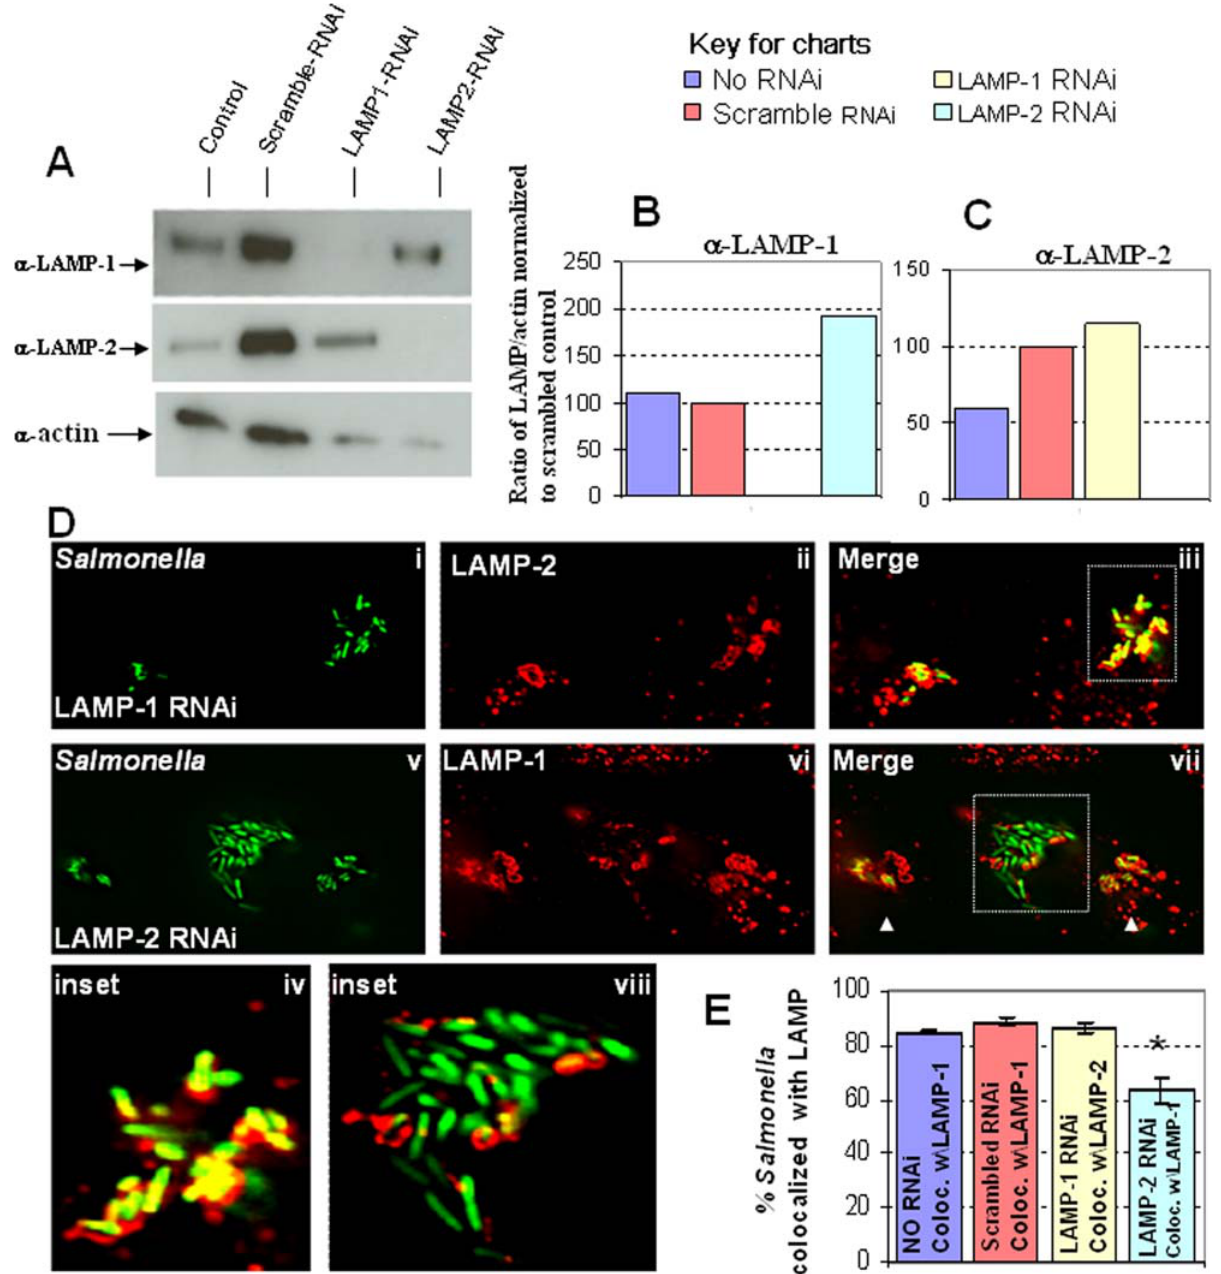
Figure 3. LAMP-2 knockdown increases prevalence of LAMP-1 depleted bacteria. A. RNAi treated HeLa cells were lysed 48 hours after RNAi treatment was initiated. Equal volumes of whole cell lysates were analyzed by Western for LAMP-1, LAMP-2 and actin (used as a loading control). B. LAMP-1:actin ratio relative to that in scrambled RNAi samples (set to 100) C. LAMP-2:actin ratio relative to that in scrambled RNAi samples (set to 100). The data in A–C show that LAMP-1 RNAi specifically knocks down LAMP-1 but not LAMP-2. In addition, LAMP-2 RNAi specifically knocks down LAMP-2 and not LAMP-1 D. HeLa cells were transfected with RNAi oligos to knockdown either LAMP-1 (i–iv) or LAMP-2 (v–ix). 48 hours after RNAi treatment, the cells were infected with Salmonella for 6 hours. The cells were then fixed and immuno-stained. LAMP-1 knockdown cells were immuno-stained for LAMP-2 and revealed consistent colocalization of Salmonella with LAMP-2 (iv). However, immuno-staining of LAMP-2 knockdown cells for LAMP-1 revealed reduced association of LAMP-1 in a subset of bacterial clusters (viii). Clusters of bacteria containing normal levels of LAMP-2 are shown by arrow heads. E. Volocity quantitation of bacteria association with LAMP-containing membrane in knockdown cells. A two-tailed P value was obtained from the Volocity quantitation using the Student’s T test. Asterisk indicates the P value is less than 0.001 which indicates that the difference is significant.